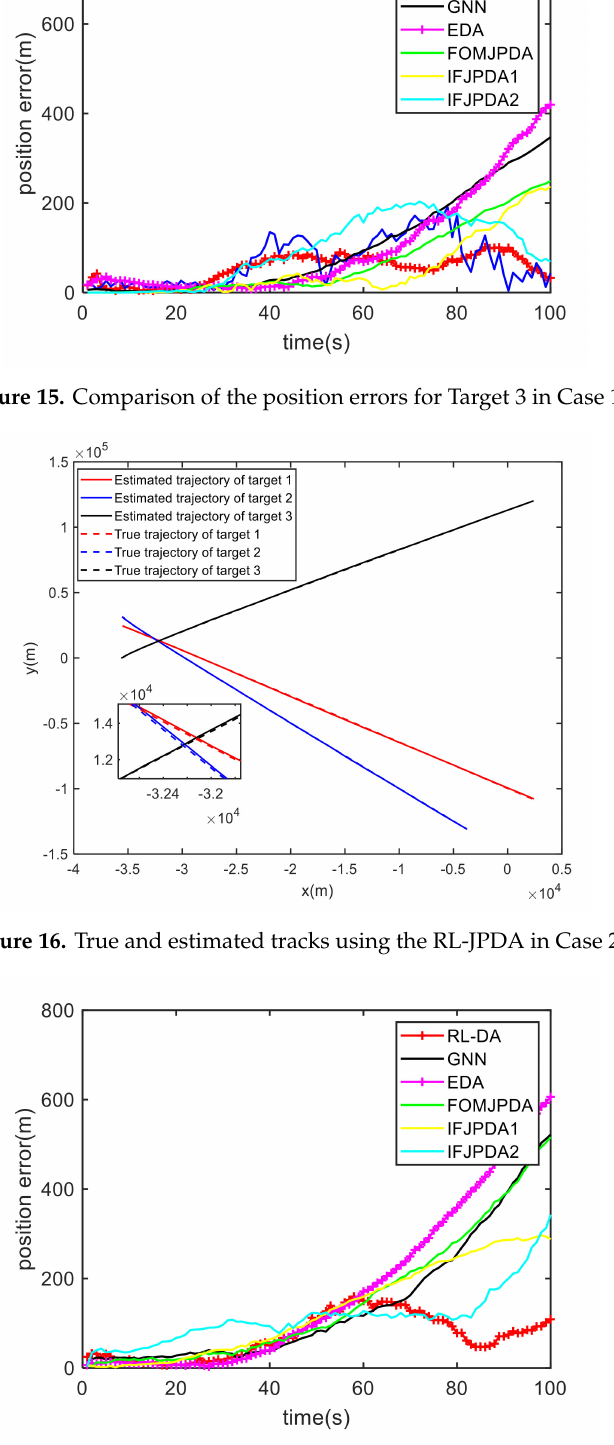
Figure 17. Comparison of the position errors for Target 1 in Case